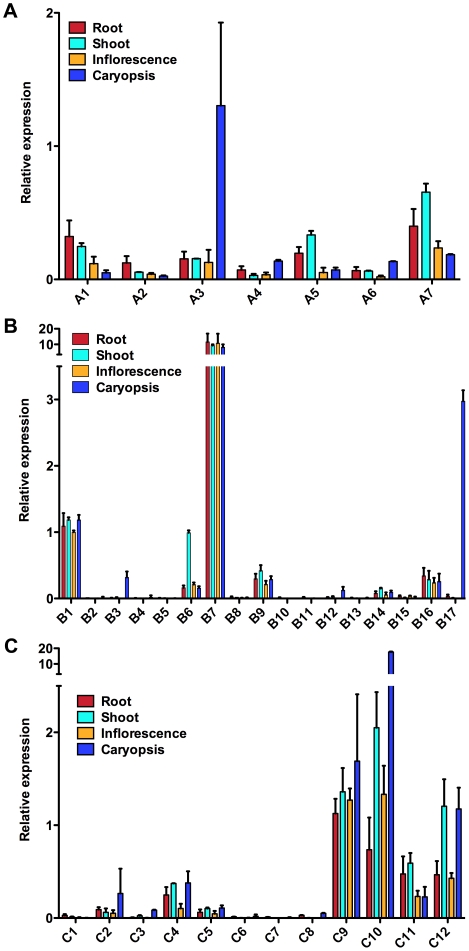

BdNF-Y expression analyses by qRT-PCR.
A) Expression of BdNF-YA genes. Note that the qPCR data from all primer sets are calibrated with their standard curves from genomic DNA so that expression can be compared for different tissues for a single BdNF-Y and between different BdNF-Y (see Methods). B) Expression of BdNF-YB genes. Note that a segmented Y-axis and bars are used to accommodate the uniformly high expression level of BdNF-YB7. C) Expression of BdNF-YC genes. As in 5B, a segmented Y-axis and bar is used to accommodate high expression in BdNF-YC10, specifically in the caryopses.